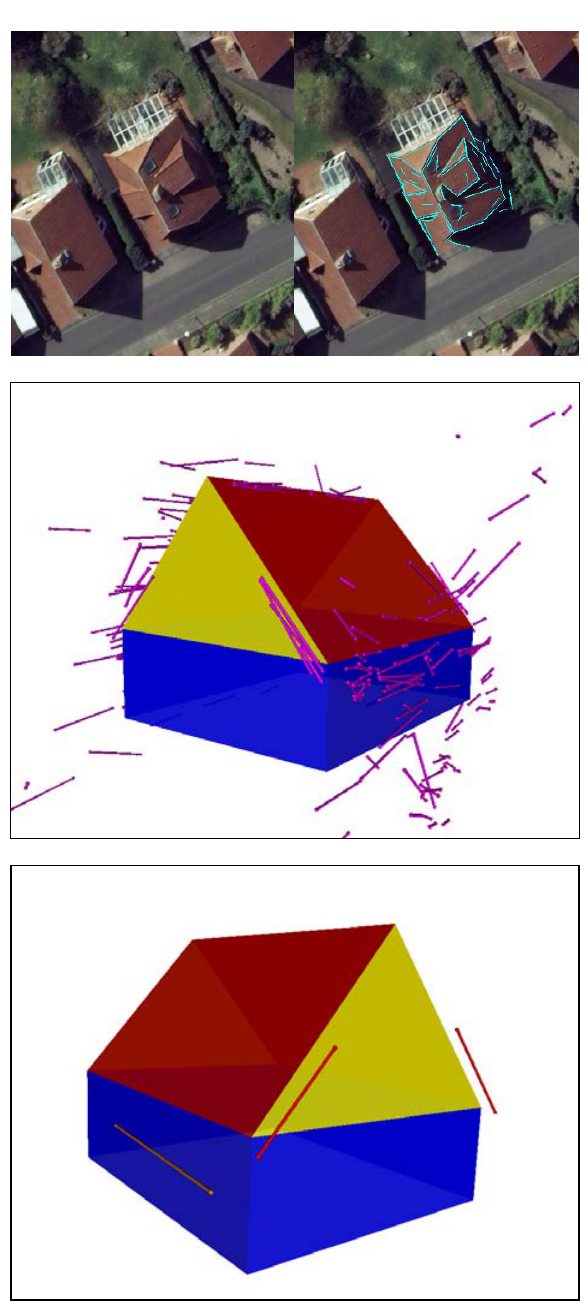
Figure 3. Steps within the Image Based Verification Step. Top: Processed building in one perspective and the roof based edge extraction. Middle: The set of 3D edges after the first filtering. Bottom: The selected edges as the base of the image based rating and the edge